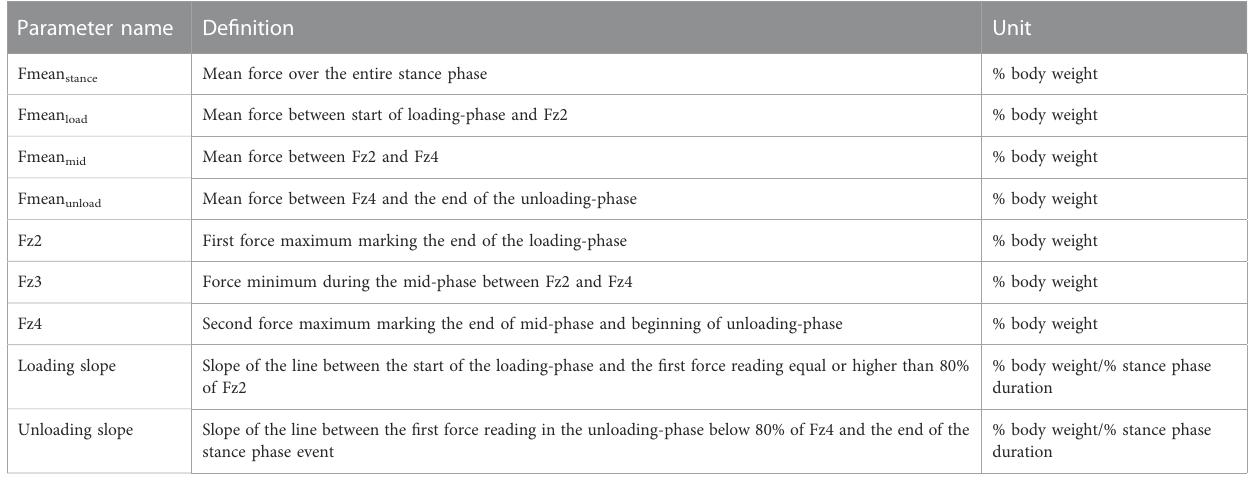
TABLE 1 Parameter de fi nitions and